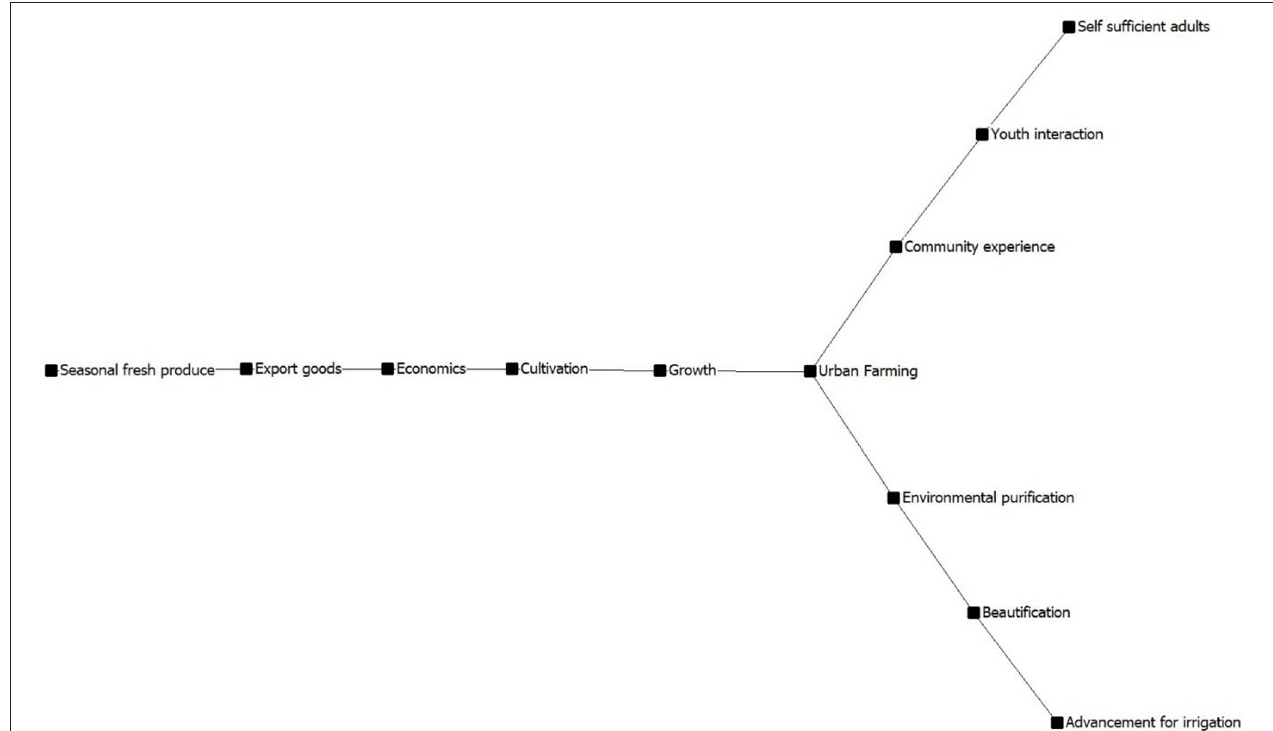
FIGURE 5 | Example of an individual network 3 (location 2, ID